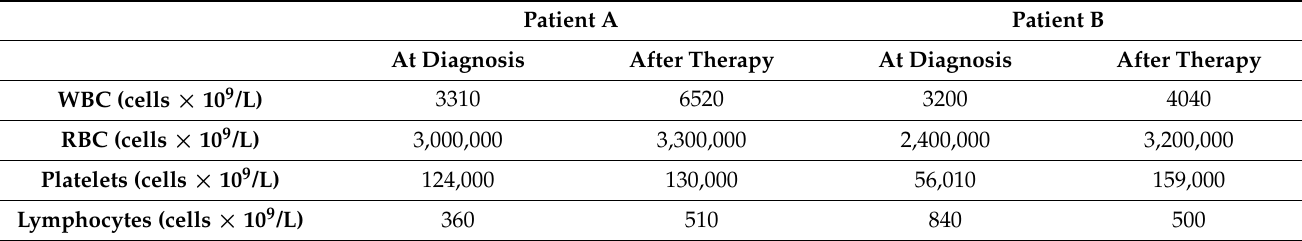
Table 1. Haematological data in patients before and 14 days after Tocilizumab. Patient A Patient